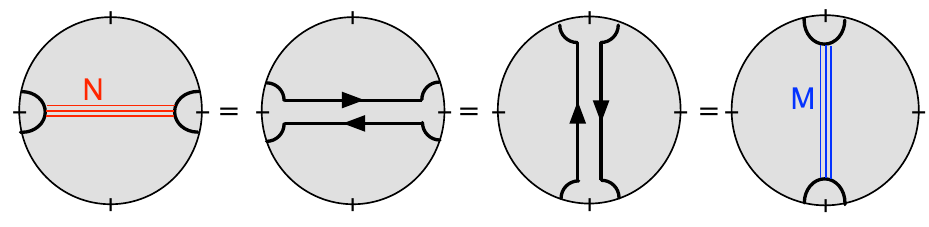
Figure 10. The chiral ring relation as realized in the dual geometry: N fundamental strings between the D5-brane poles are equivalent to a D3-brane wrapping the sum of the two D5-brane cycles, which is equivalent to a D3-brane wrapping the sum of the two NS5-brane cycles, which in turn is equivalent to M D1-branes between the NS5-brane